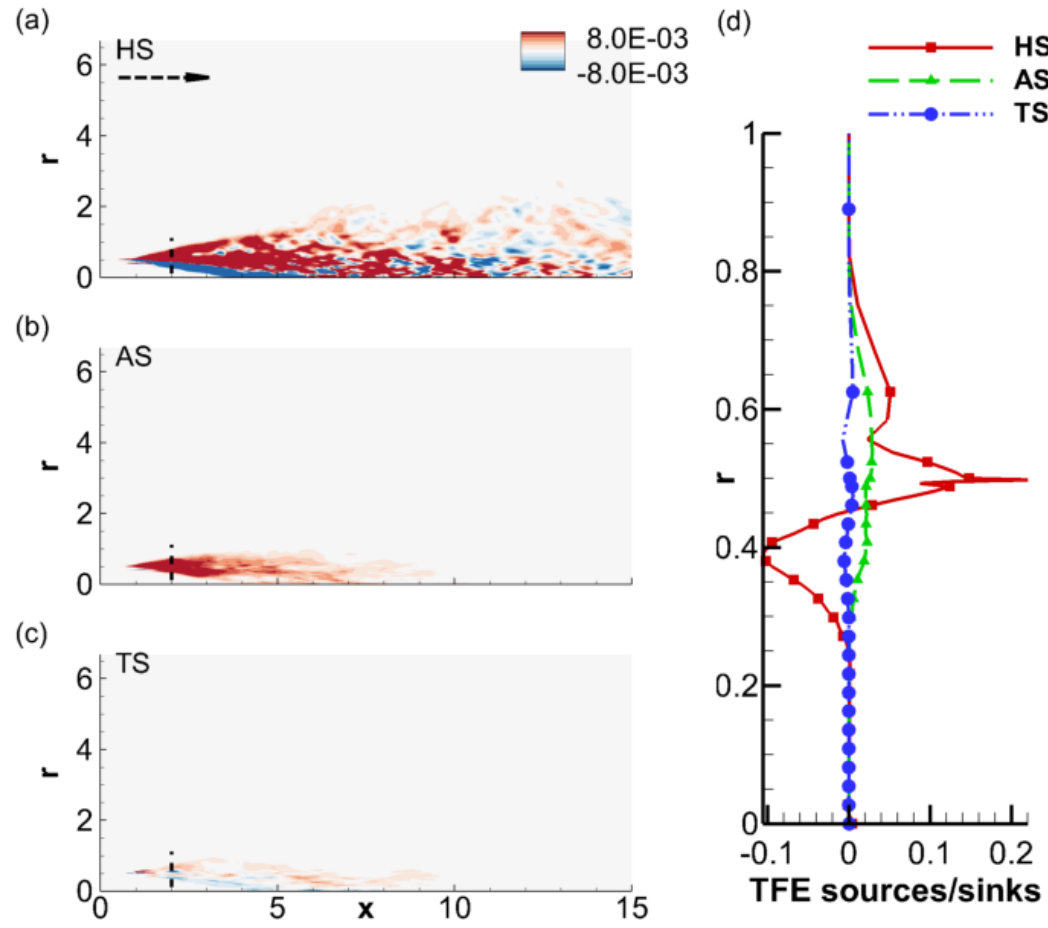
Figure 10. Mean ( a ) hydrodynamic; ( b ) acoustic and ( c ) thermal sources of TFE; ( d ) Radial profile of the three source terms along the dotted vertical line at x = 2, shown in ( a ). The horizontal dotted arrow in ( a ) marks the mean-flow direction of the jet. Frames a , b , and c share the same abscissa and